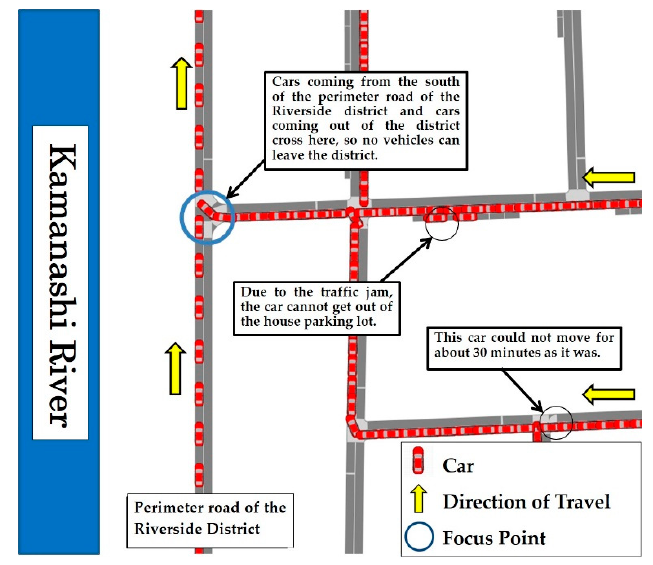
Figure 4. A screenshot of evacuation simulation by car used for explanatory material.